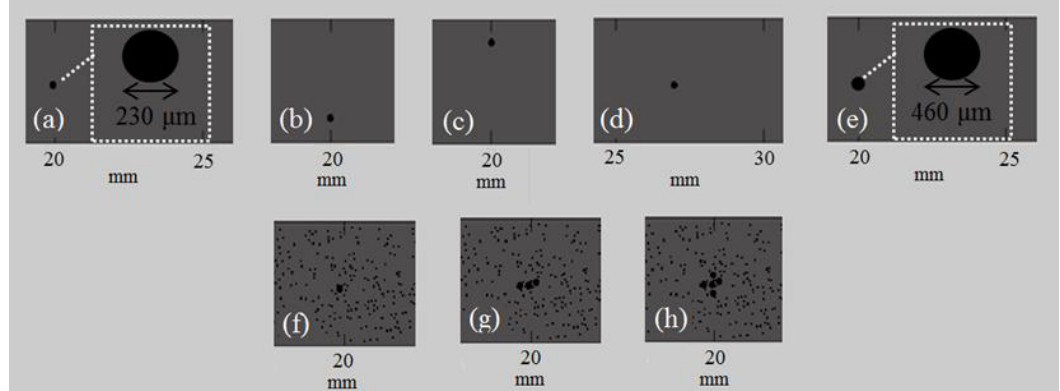
Figure 3. Numerical models of cortical bone corresponding to the second set of simulations (Series II_RL) focusing on the regions of the occurrence of RL: ( a ) homogeneous bone, 1 RL with center coordinates ( x , y ) = (20, 2); ( b ) homogeneous bone, 1 RL with center coordinates ( x , y ) = (20, 3); ( c ) homogeneous bone, 1 RL with center coordinates ( x , y ) = (20, 1); ( d ) homogeneous bone, 1 RL with center coordinates ( x , y ) = (27, 2) mm; ( e ) homogeneous bone, 1 RL with center coordinates ( x , y ) = (20, 2) and double the diameter; ( f ) B_Po5_RL1; ( g ) B_Po5_RL3; ( h ) B_Po5_RL5.